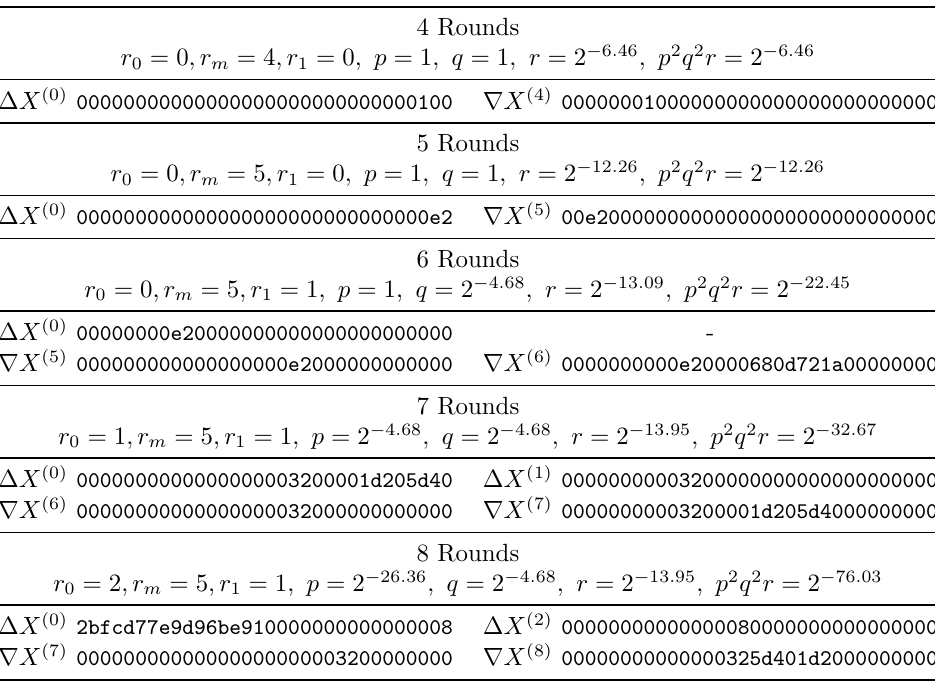
Table 11: Sandwich distinguishers for 4 to 8 rounds of CLEFIA (with final permutation). 4 Rounds